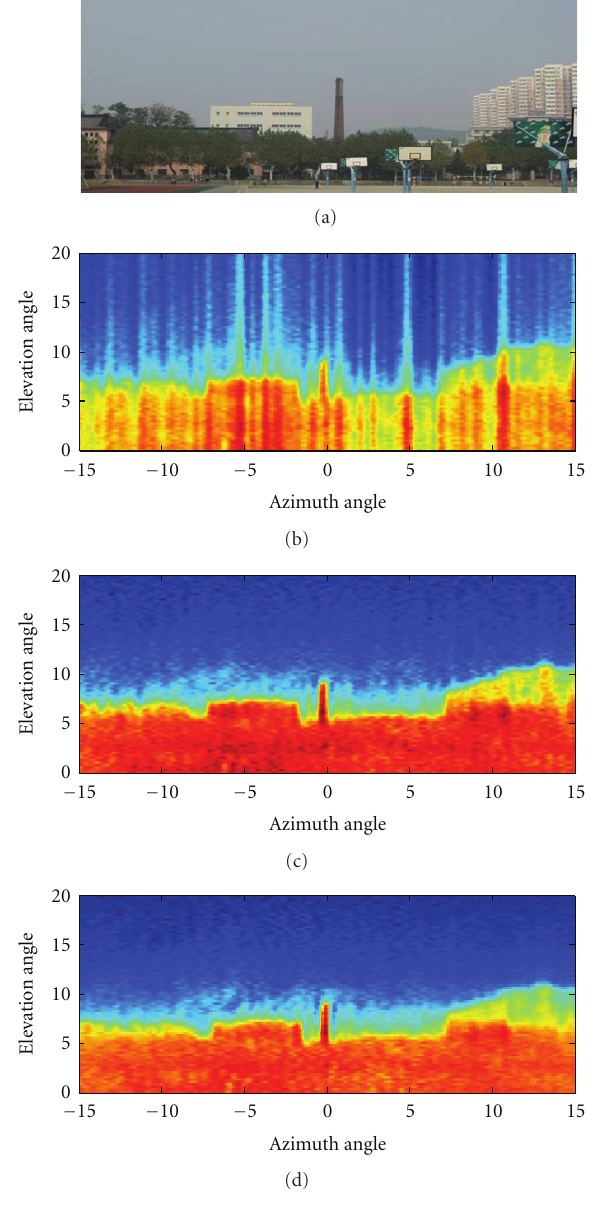
Figure 4: Images of the campus playground within a wide FOV; (a) optic image; (b) the original brightness temperature image without mutual coupling compensation; (c) the calibrated brightness tem- perature image using the “di ff erence scene measurement” method; (d) the calibrated brightness temperature image using the G-matrix